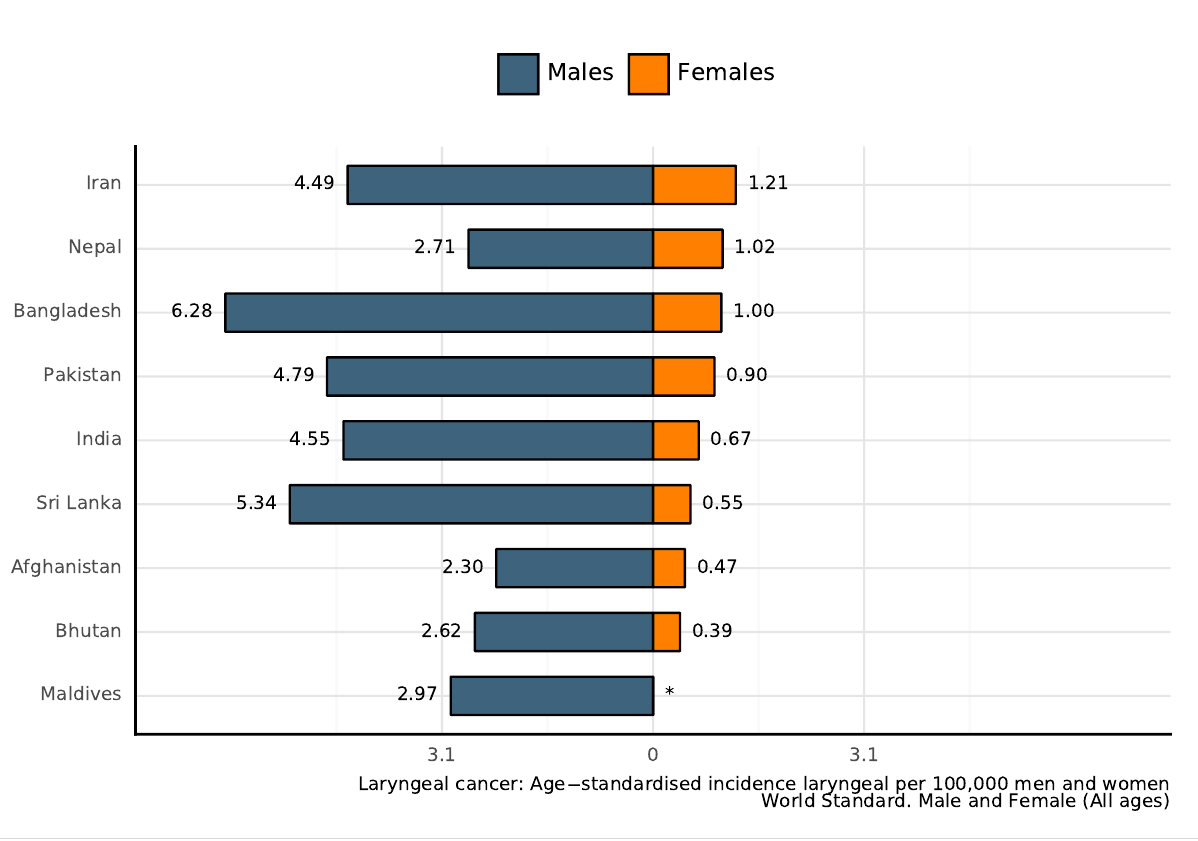
Figure 100: Age-standardised incidence rates of laryngeal cancer of India (estimates for 2020)